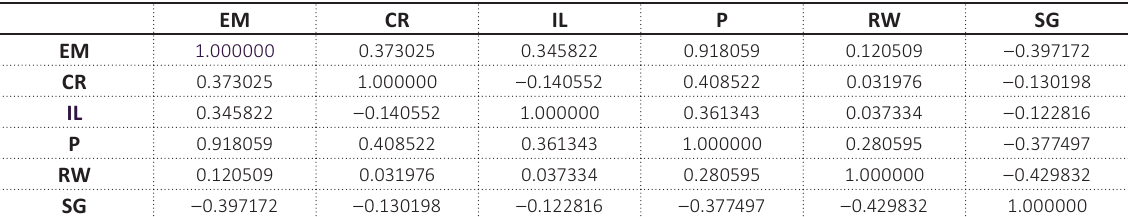
Table 3. Correlation matrix (EViews screen result) for the dependence between the emigrants from Ukraine (EM) and the set of the internal